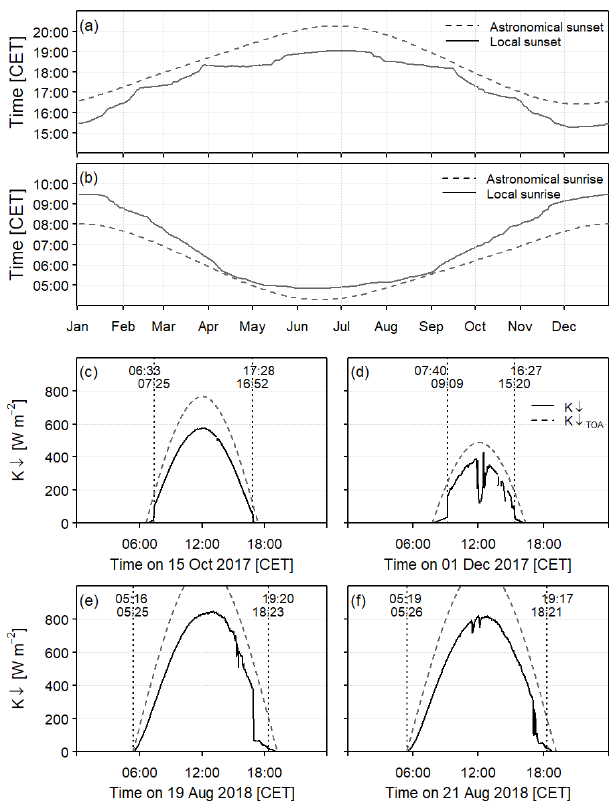
Figure 9. Time of local and astronomical (a) sunset and (b) sun- rise at IAO. Observed incoming shortwave radiation (1min data) for example days, illustrating the effect of (c, d) orographic shad- ing and (e, f) orographic shading plus afternoon cloud cover around the surrounding peaks. In panels (c) – (f) , local sunrise and sunset are marked by dotted vertical lines, and the times of local and as- tronomical sunrise and sunset are shown. The incoming shortwave radiation at the top of the atmosphere K ↓ TOA is also shown (see text for